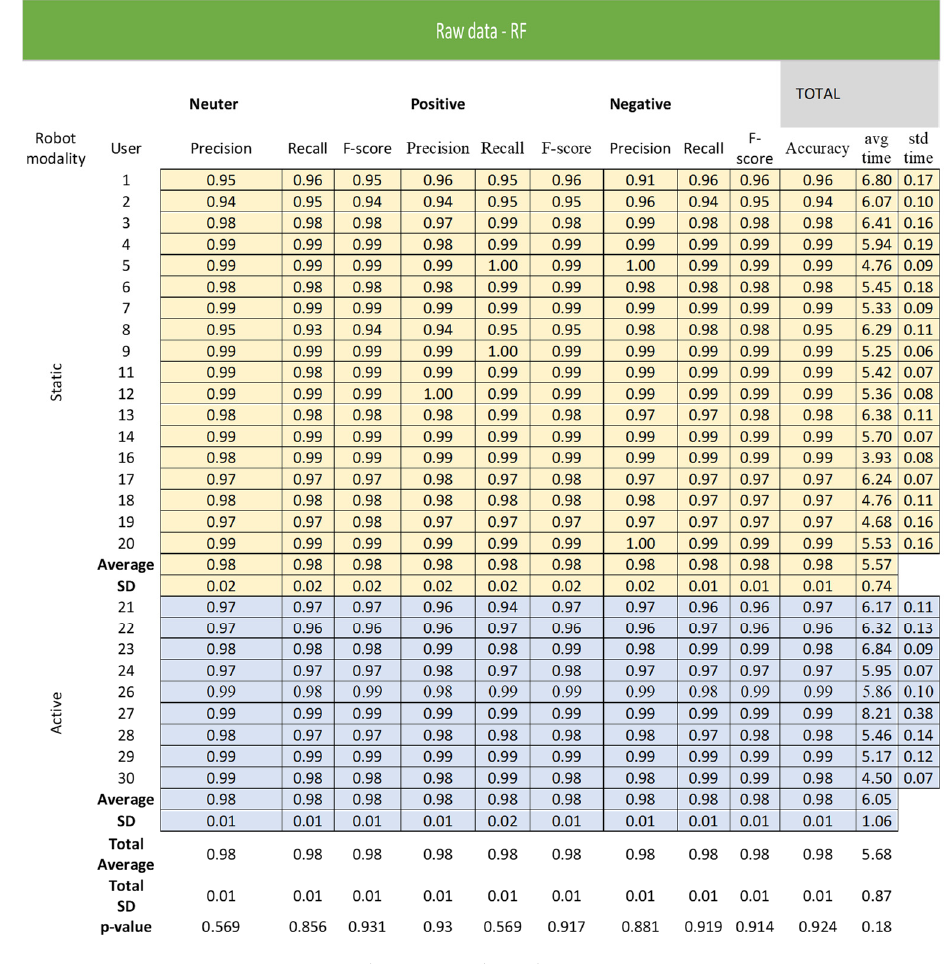
Figure 6. Raw representation according to RF algorithm. Table 4. Usability and acceptability post-robot